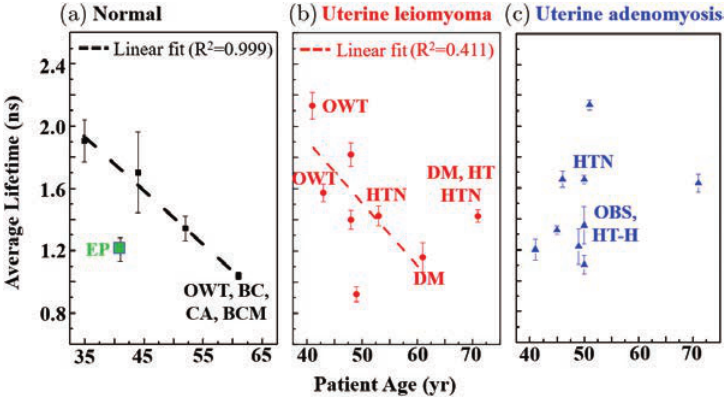
Fig. 4. Scatter plots of average °uorescence lifetime versus patient age, (a) normal, (b) uterine leiomyomas and (c) uterine adenomyosis. The dash lines in (a) and (b) were linear ¯tted lines. The green square in (a) was excluded for ¯tting, because the patient was found multiple endometrial polyps 14 months later. The patients ages, chronic diseases and medical histories are in Table 1. EP: endometrial polyps; BC: breast cancer; CA: colon adenomas; BCM: breast cancer metastasis; DM: diabetes mellitus; HT: hyperthyroidism; HT-H: hypothyroidism; HTN: hypertension; OBS: obesity; OWT: overweight. The data were from the images detected by the single-channel TCSPC